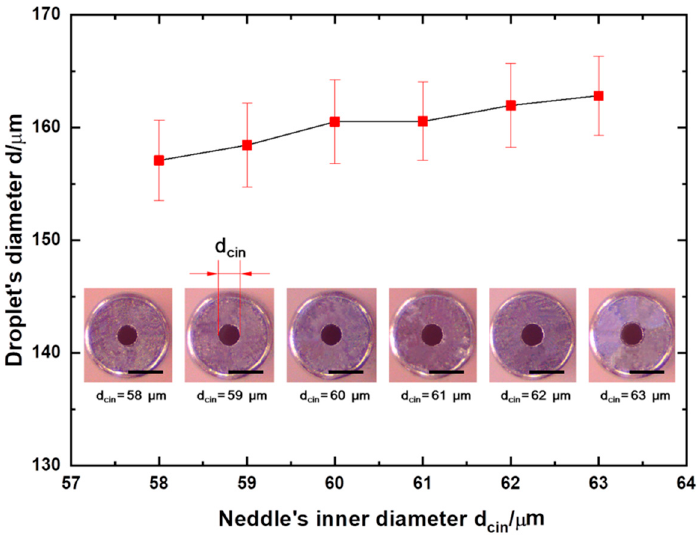
Figure 4. Experiments with different capillary inner diameters. Experiments were carried out when centrifugal acceleration a tip was held constant (108 g ). Error bars given are standard deviations (SDs). Scale bars: 100 μ m.